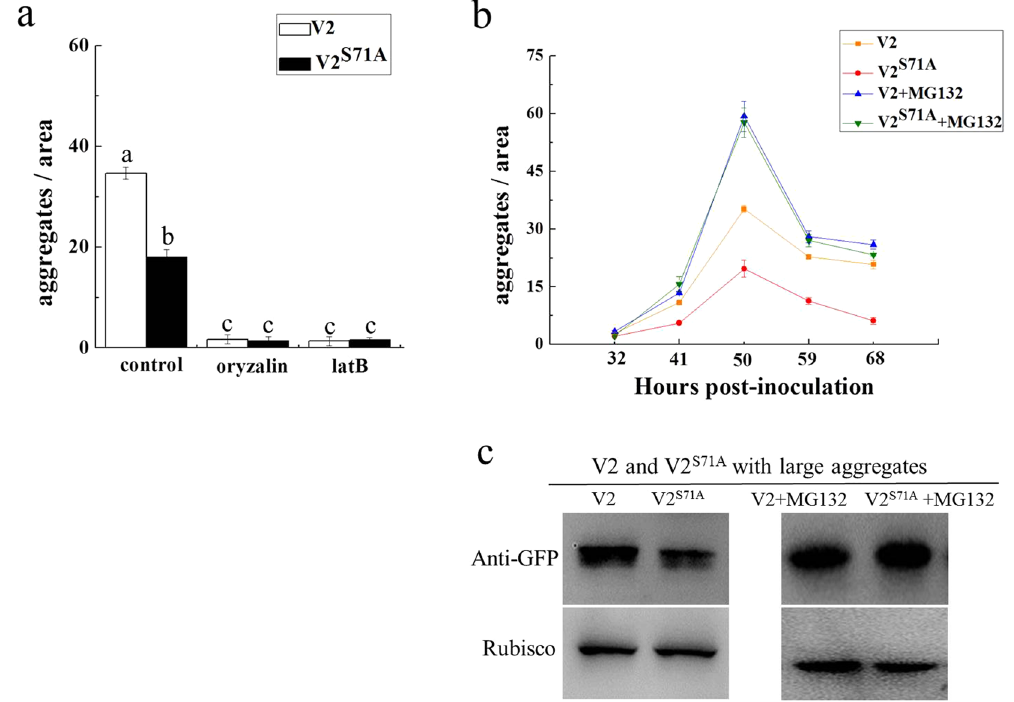
Figure 4. Inhibition of the cytoskeleton and the 26S proteasome lead to changes in the number of V2-YFP and V2 S71A -YFP large aggregates in N. benthamiana . ( a ) Number of large aggregates in latB-treated cells and oryzalin-treated cells. Bars and numbers indicate the mean sizes of aggregates as measured for leaf areas of 4 mm 2 in 10 independent experiments for each treatment. Different lowercase letters above the bars denote significant differences (Fisher’s LSD method; P < 0.05). ( b ) Number of large aggregates in MG132-treated cells. The average number of aggregates as measured for leaf areas of 4 mm 2 in 10 independent experiments for each treatment. ( c ) Western blot analysis V2 and V2 S71A in large aggregates with or without